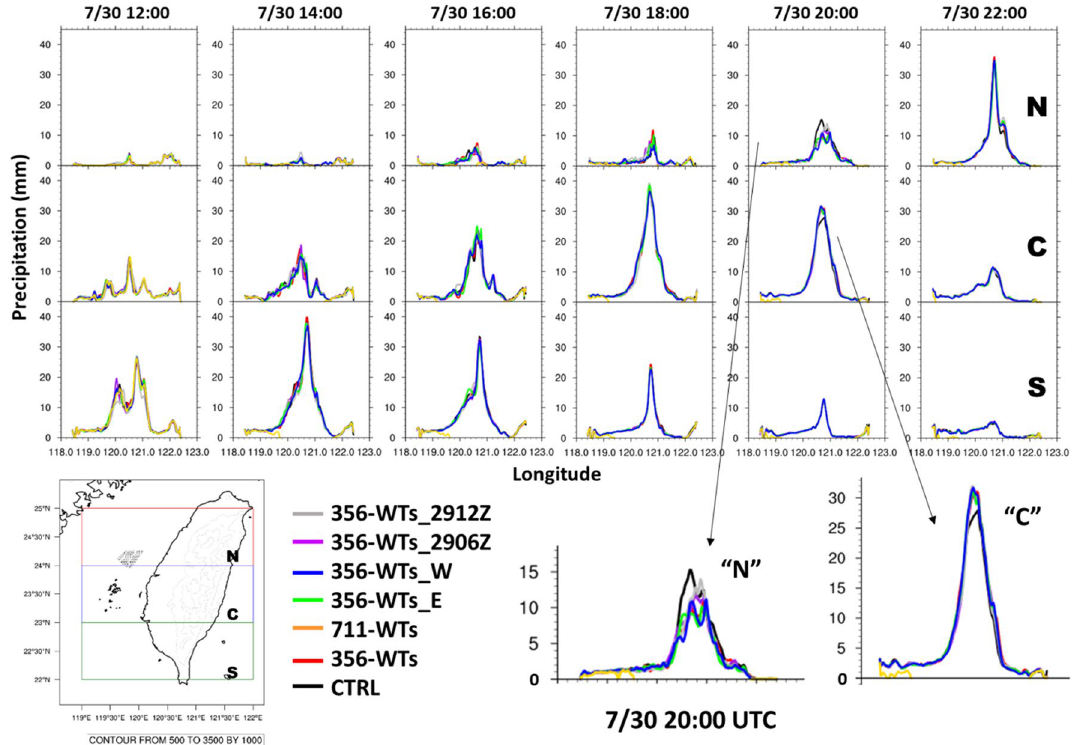
Figure 9. The evolution of hourly precipitation over three regions for all experiments during 12:00–22:00 UTC on July 30, 2017. North, central and south region denoted by “N”, “C”, and “S”, respectively. Maps and plots were produced using NCAR Command Language (NCL) version 6.6.2 37